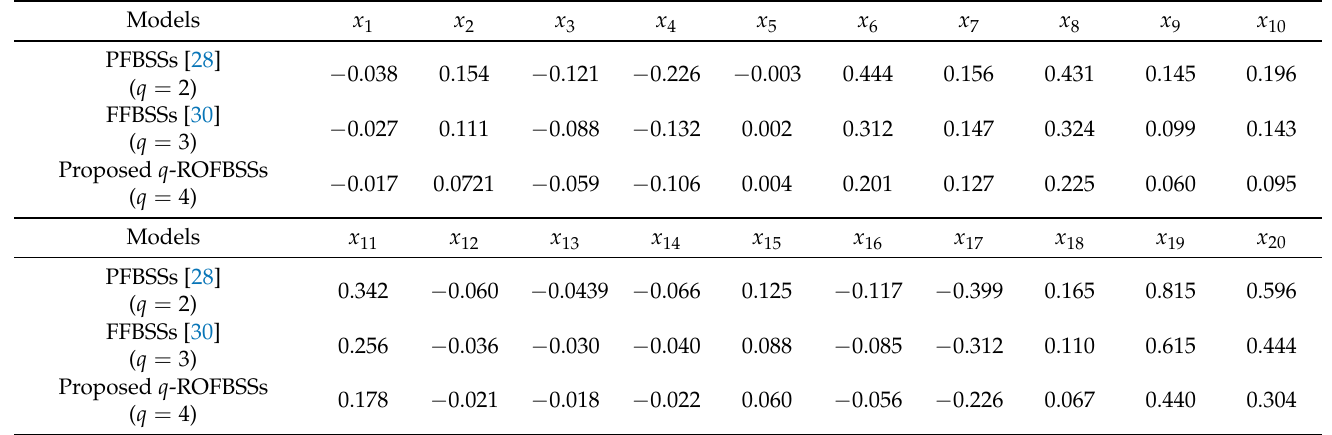
Table 17. Comparison table for the Application 1 (Selection of an employee) in [28].